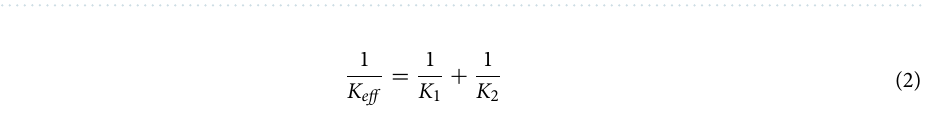
Figure 8. Cross-sections of the selected ROIs of the samples: (a) S3u, (b) S5u, (c) S7u, and (d) S9u (figure created using Fiji 1.5 software https